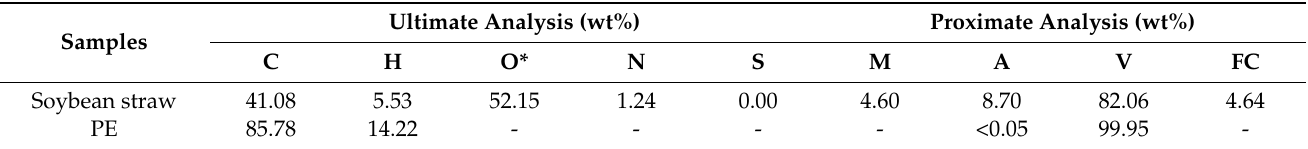
Table 3. Proximate and ultimate analysis of Soybean straw and